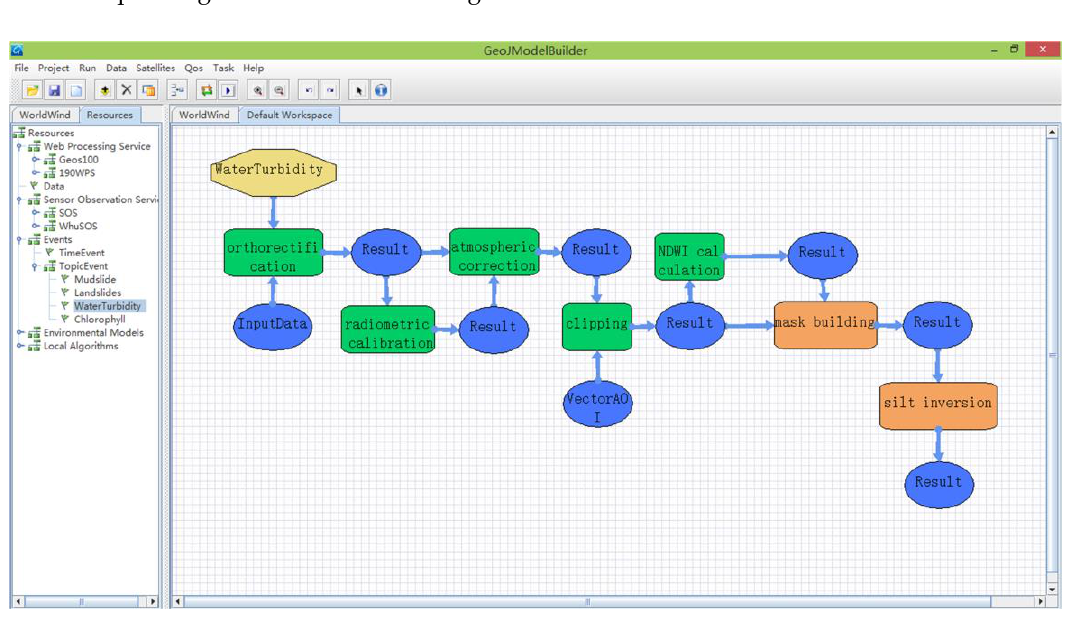
Figure A1. The execution and monitoring of the processes executed as part of the turbidity extraction geoprocessing workflow.